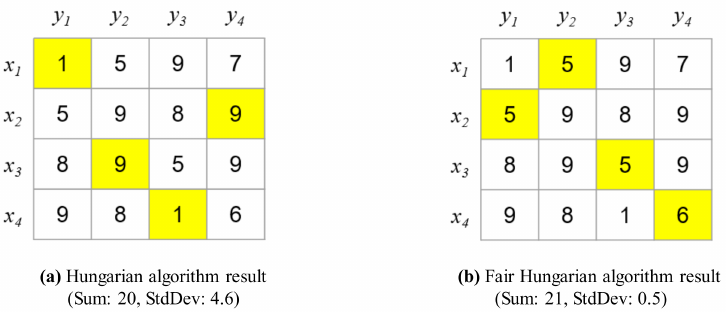
Figure 16. Comparison between the results of the Hungarian and Fair Hungarian